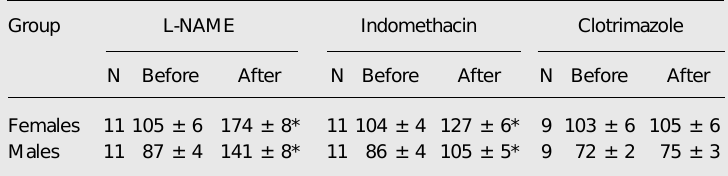
Table 2. Coronary perfusion pressure of isolated hearts from female and male rats before and after perfusion with 100 µM L-NAME, 2.8 µM indomethacin or 0.75 µM clotrimazole.